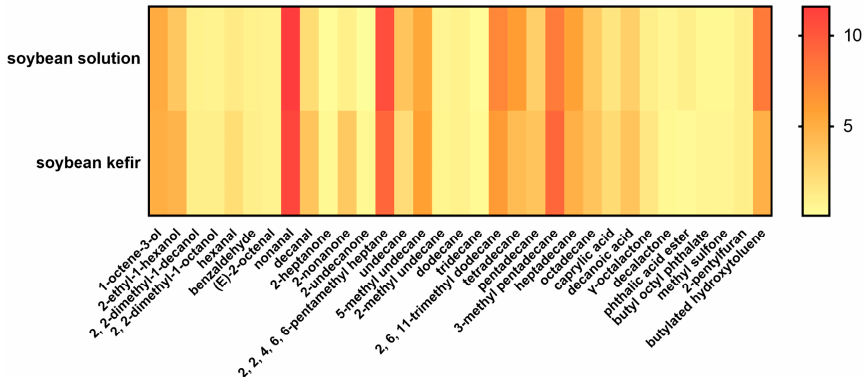
Figure 8. The volatile flavor contents of soybean solution and soybean kefir.